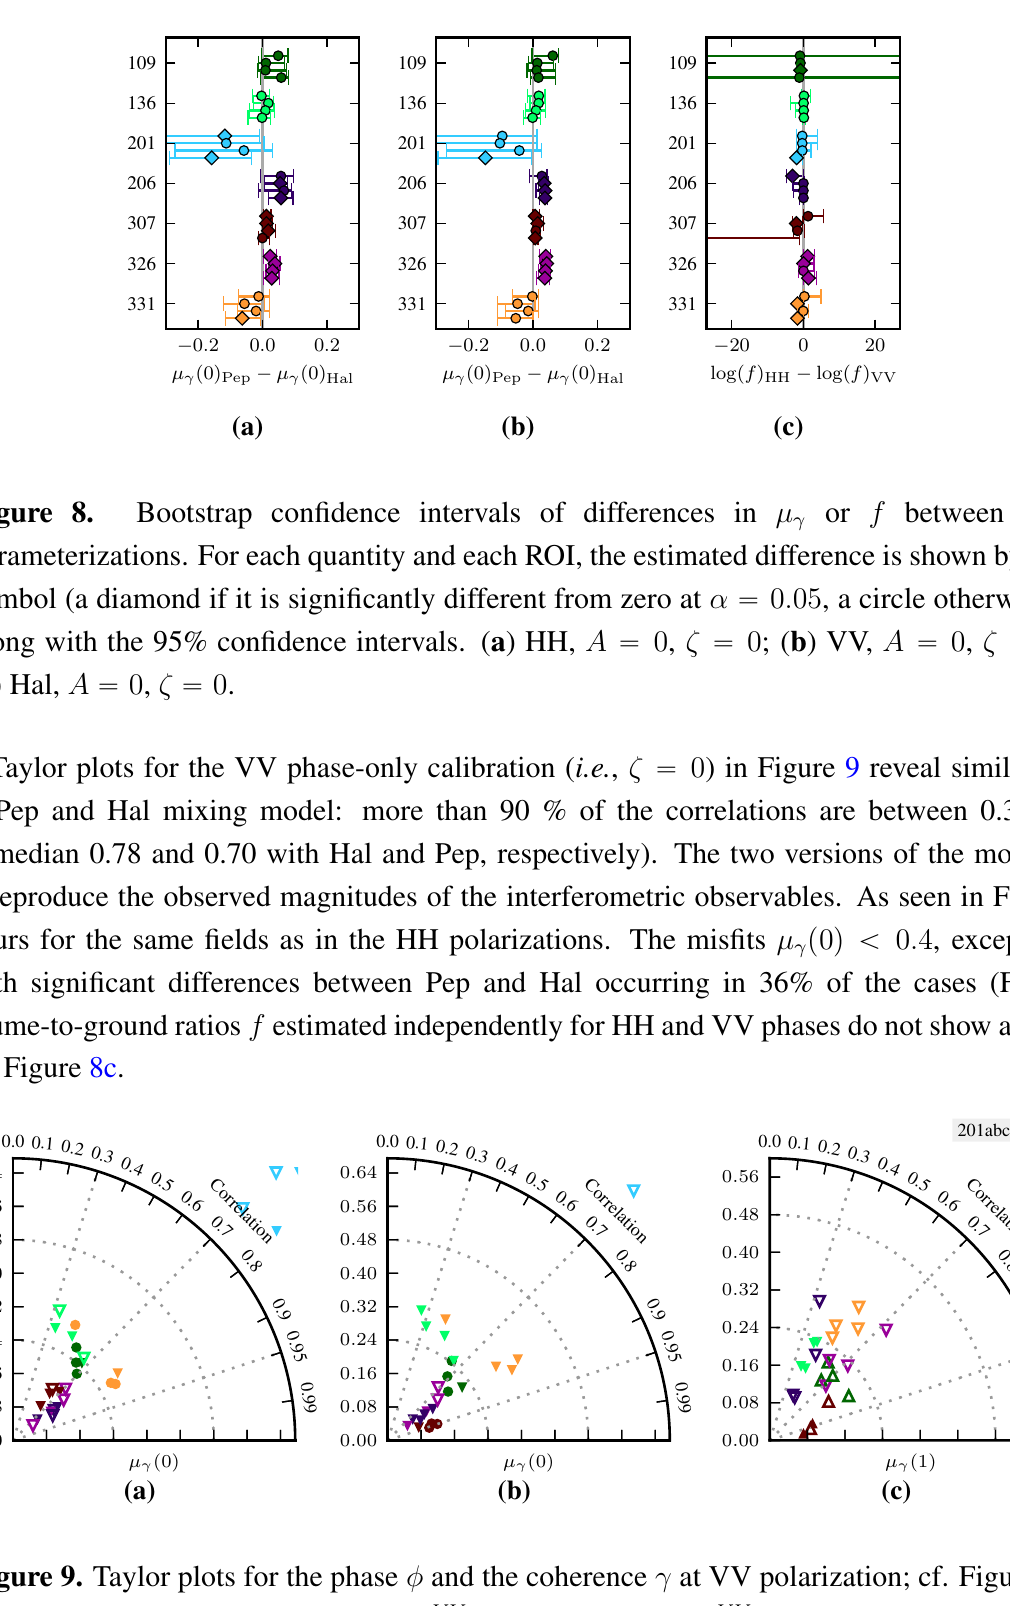
corresponding to confidence intervals that overlap with µ two mixing models.